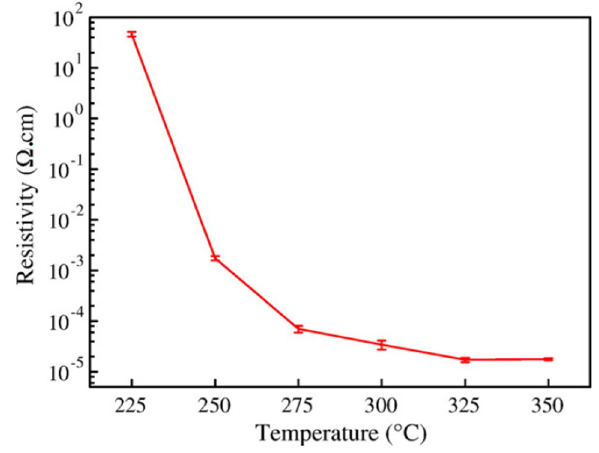
Figure 11. Decreasing the resistivity of a thin film compose of Cu NPs by increasing the sintering temperature. Reproduced with permission from [40]. Copyright 2006 Elsevier Publishing.